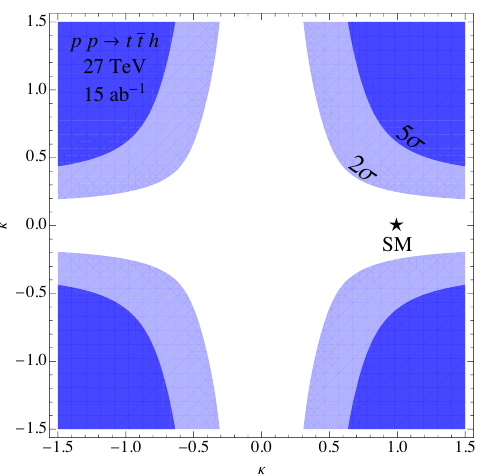
Figure 8 . The 2 (cid:27) and 5 (cid:27) expected exclusion regions for measuring a null result of O 6 (3.8) at the HE-LHC with 15 ab (cid:0) 1